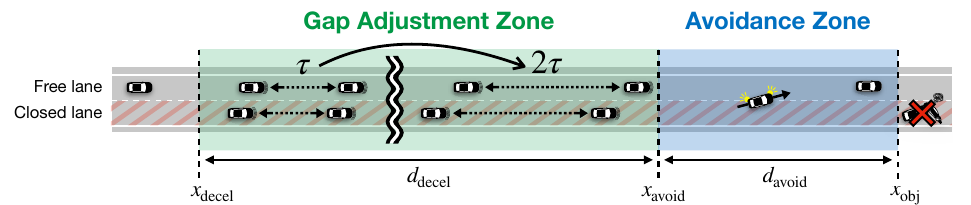
Figure 2. Control rules based on distance between an obstacle and approaching vehicles on a two-lane